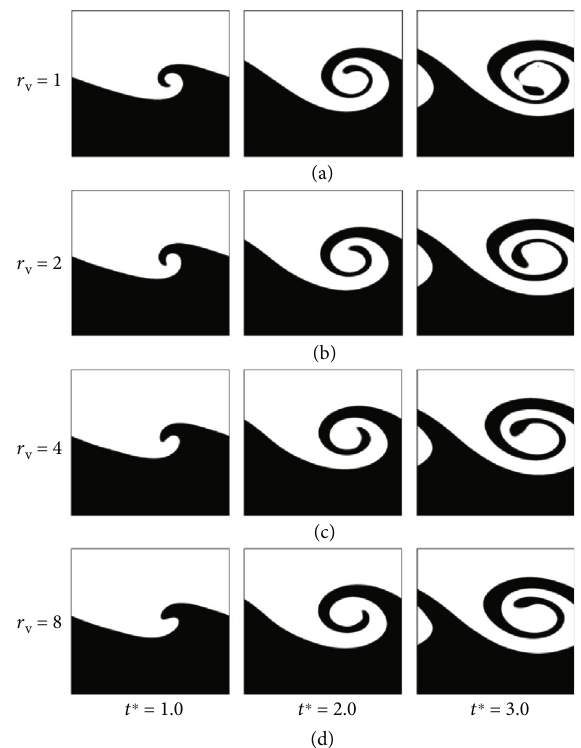
Figure 4: Snapshots of interface evolutions for di ff erent viscosity ratios ( Re = 10000 , We = 400 , and ρ